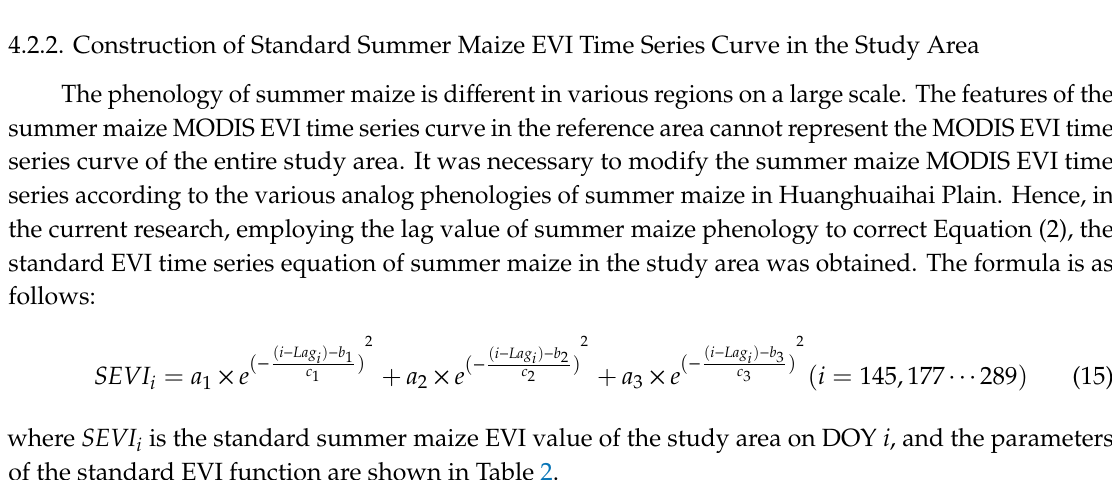
Table 3. The corresponding values of i, s , and summer maize phenology.